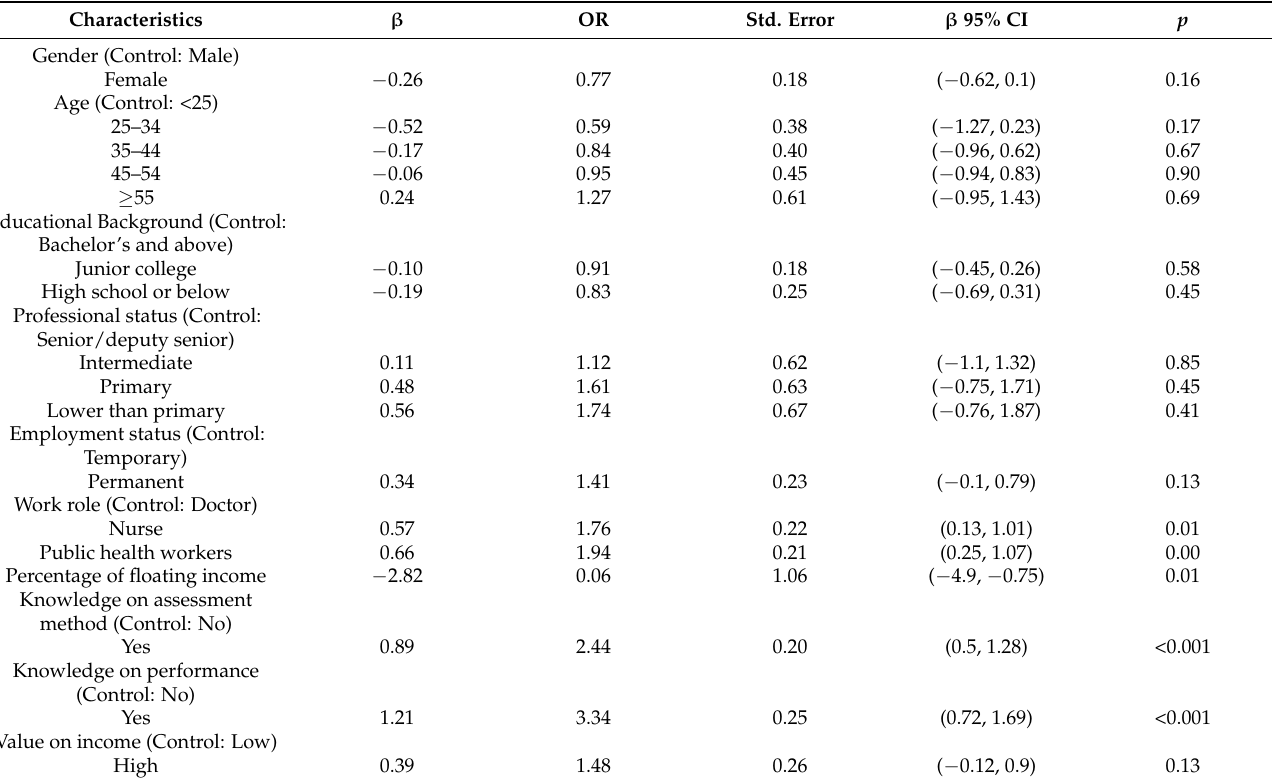
Table 2. The association between basic characteristics/PBS design and health workers’ satisfaction on payment methods (All sample). Characteristics β OR Std.